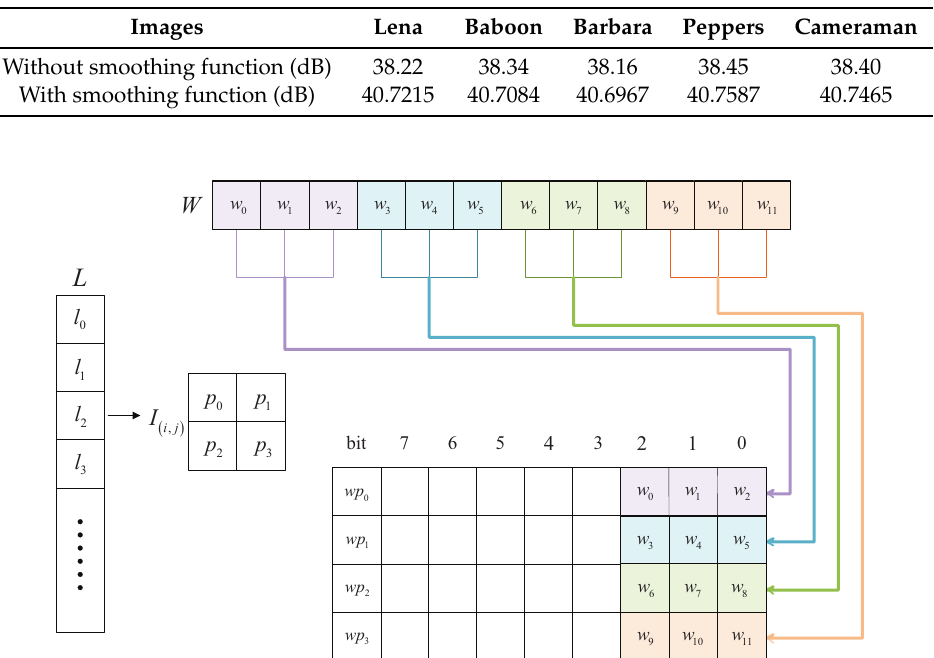
Figure 7. Watermark embedding